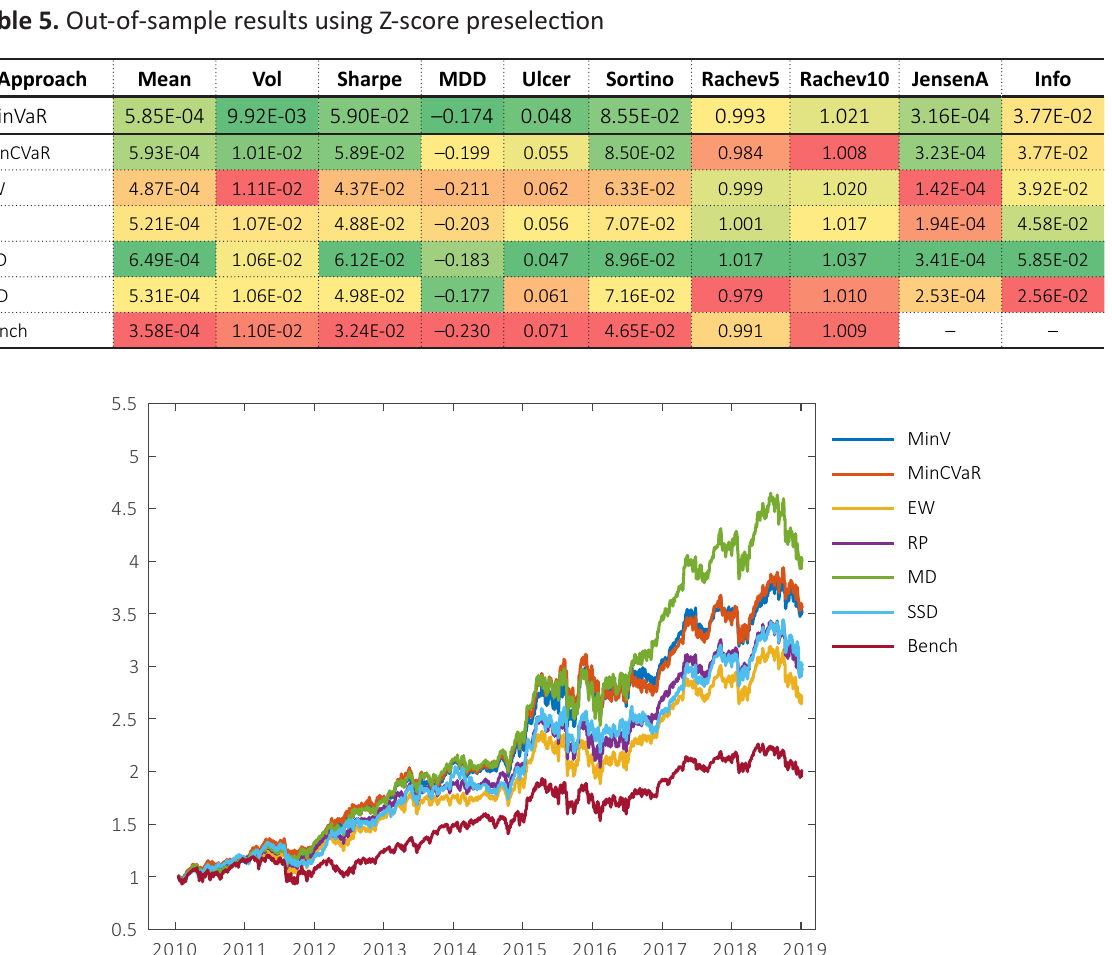
Figure 5. Out-of-sample compounded return for all models using Z-score